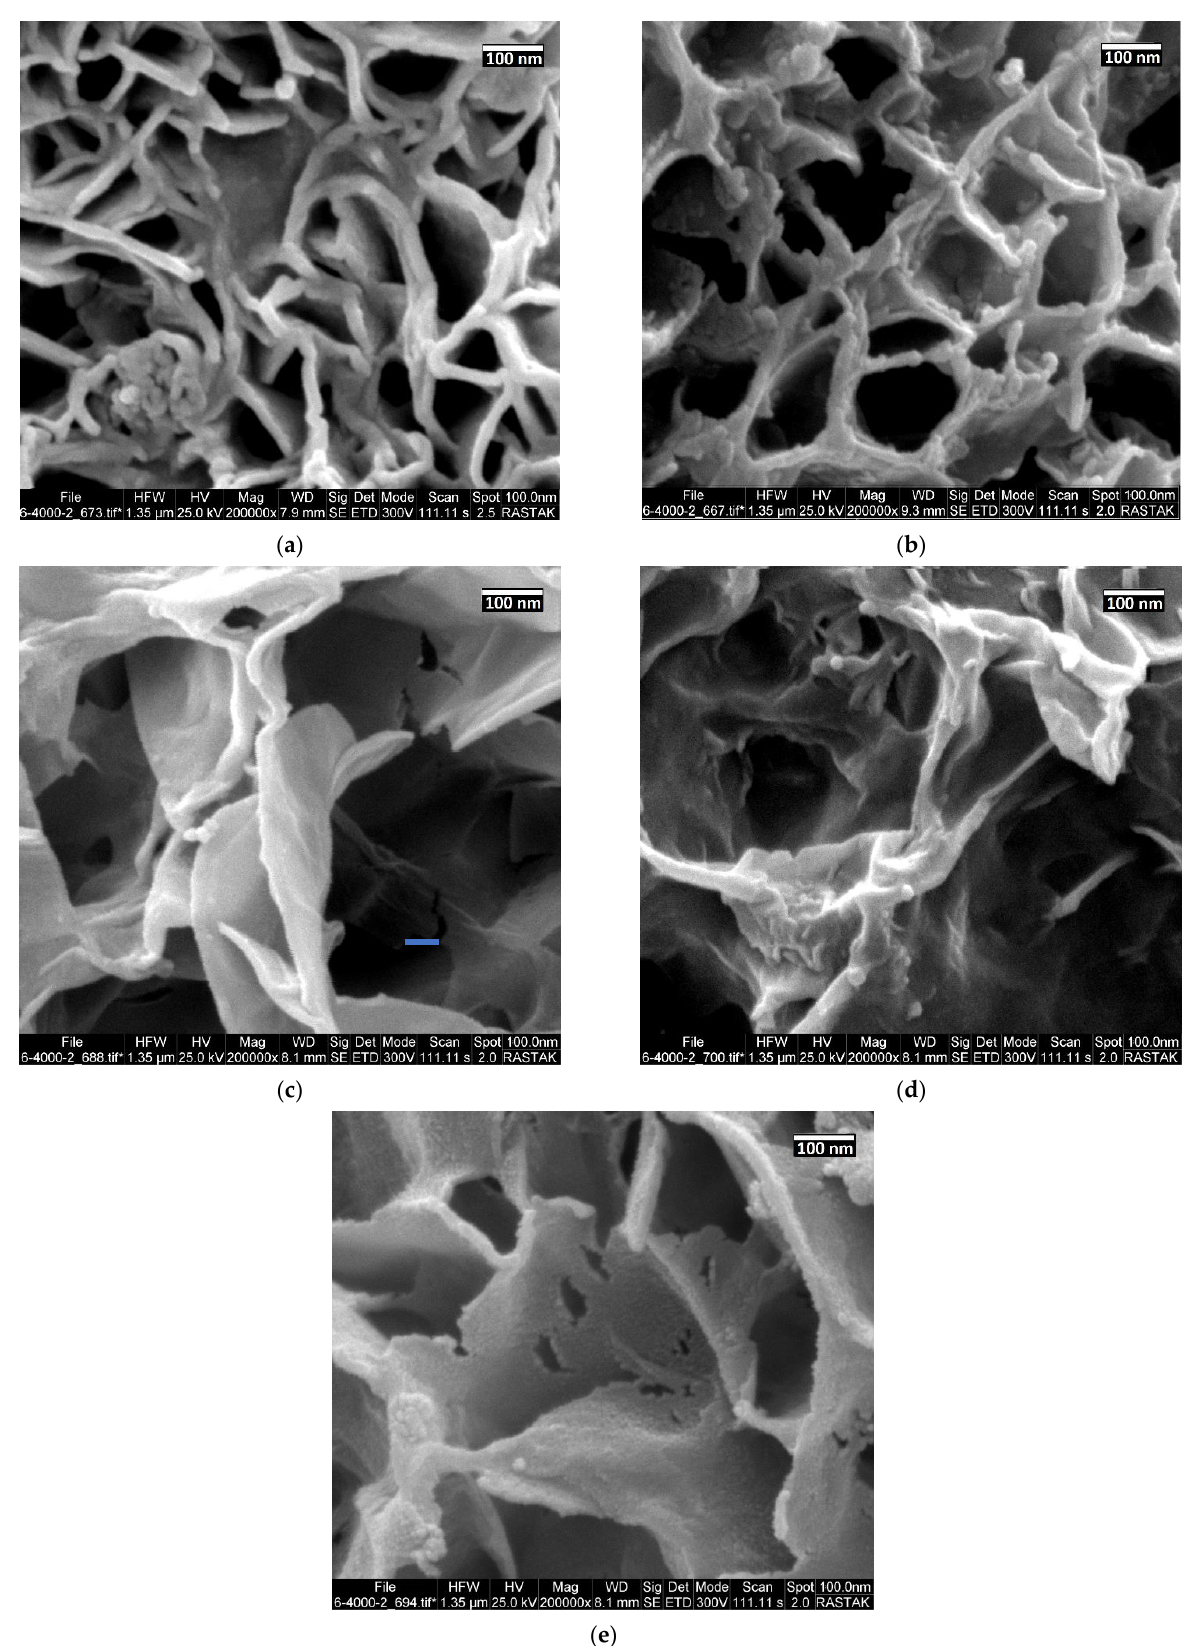
Figure 6. SEM photos related to electroplated for: ( a ) 3 h, ( b ) 4 h, ( c ) 5 h, ( d ) 6 h, ( e ) 10